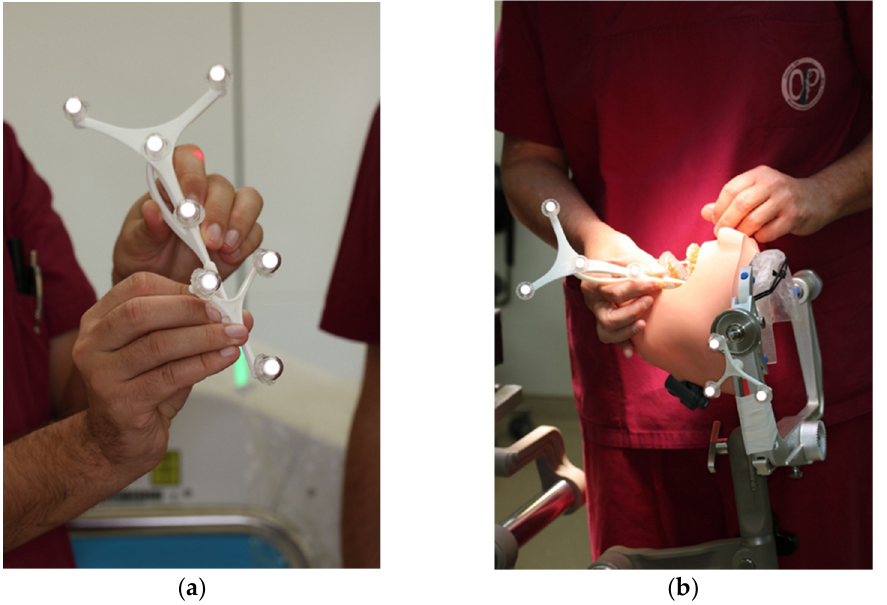
Figure 5. Registration process during trial surgery ( a ) Calibration of dynamic reference frame (DRF) and the navigation probe ( b ) Surface registration of at least 4 different anatomical landmarks